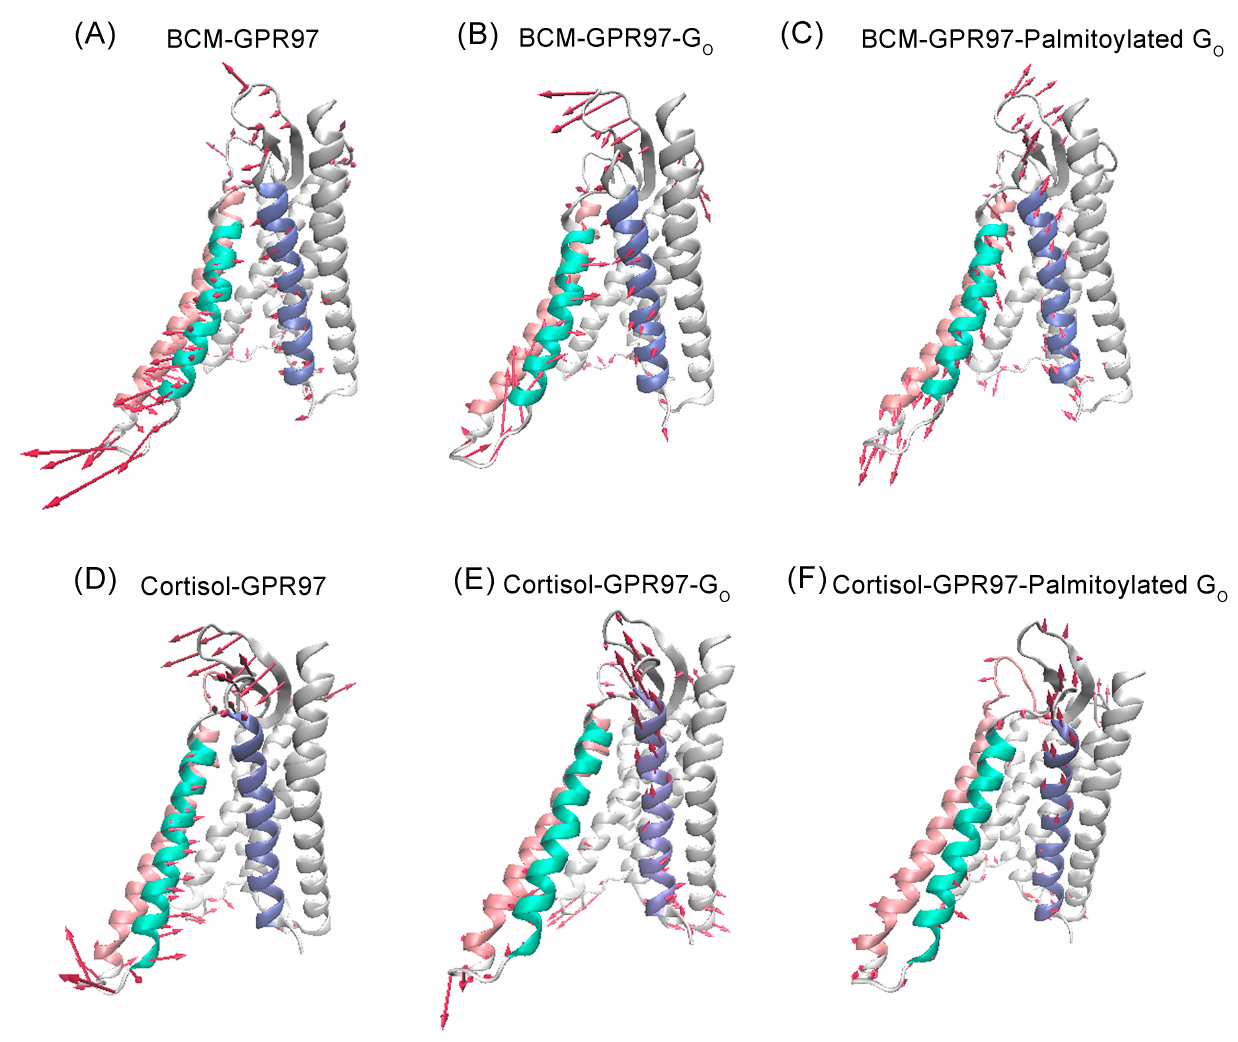
Figure 4. Comparison of the principal modes of motion along PC1 in BCM–GPR97 ( A ), BCM– GPR97–G o ( B ), BCM–GPR97–palmitoylated G o ( C ), cortisol–GPR97 ( D ), cortisol–GPR97–G o ( E ), and cortisol–GPR97–palmitoylated G o ( F ) systems. Red arrows depict the directions of protein motions, while the length of the arrows represents the magnitude of the movements. The TM5, TM6, and TM7 regions are colored red, green, and purple, respectively.